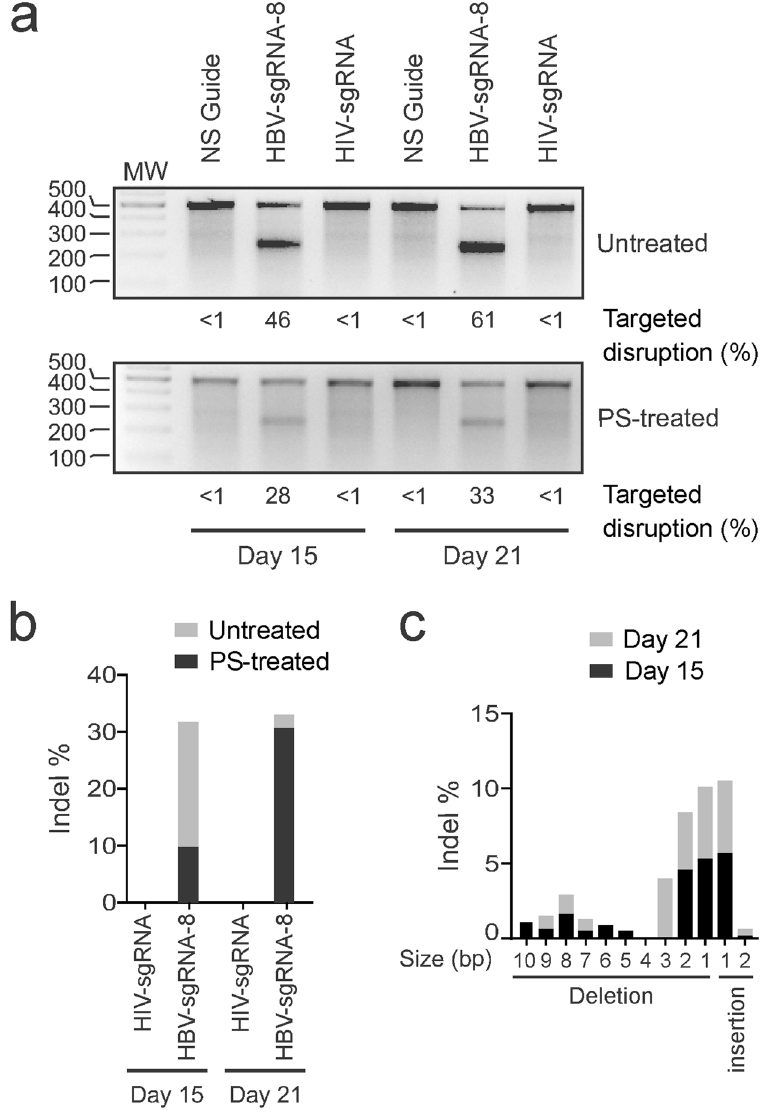
Figure 3. Targeted mutation of HBV DNA by AAV2-SaCas9-sgRNA-8. ( a ) Total DNA extracted from ssAAV- transduced cells with and without plasmid-safe (PS) treatment was subjected to T7E1 analysis to detect insertions and deletions (indels) in viral DNA. The percentages of HBV DNA sequences containing targeted mutations at 15 and 21 days after transduction are indicated for sgRNA-8 and the two control guides. ( b ) Drop-off ddPCR ™ assay to detect indels in ssAAV-transduced cells. Analysis was performed 15 and 21 days after transduction with AAV2-SaCas9-sgRNA-8 or the HIV-targeting control vector. ( c ) Tracking of indels by decomposition (TIDE) was carried out on raw Sanger sequencing chromatograms that were generated using amplicons of viral sequences as the template. Sizes of the predicted indels, together with the proportions of the total that they represent, are presented. Analysis was carried out on samples extracted from cells that had been transduced at 15 and 21 days after transduction with